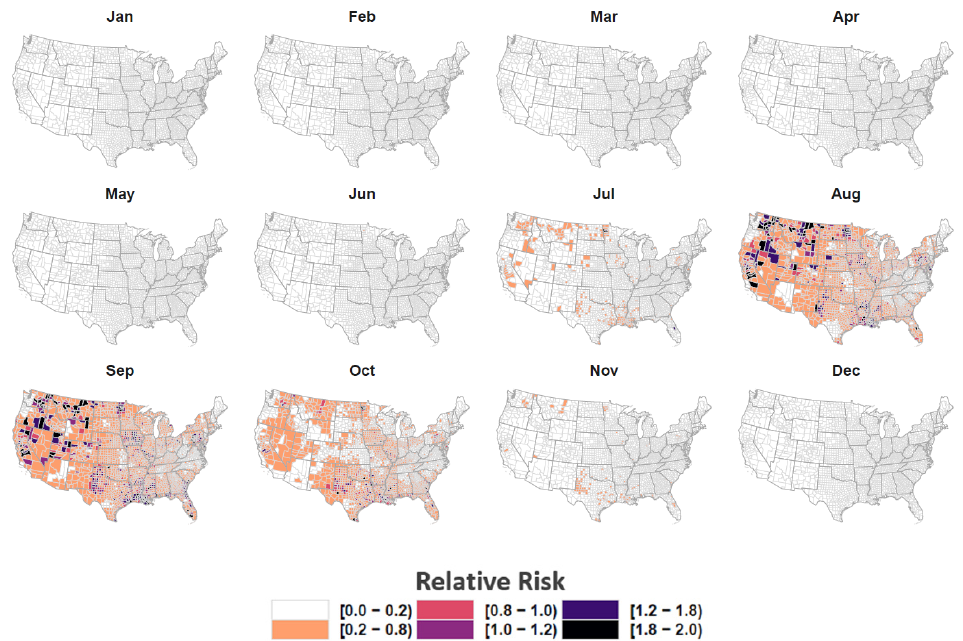
Figure A16. Spatiotemporal distribution of equine WND relative risk. Maps depict the spatial and temporal distribution of model estimated WND relative risk by US County and month of year. Maps are color coded according to legend at bottom such that darker tones signify increased risk and lighter tones represent relatively lower risk. A relative risk value of 1 indicates that model predicted cases were comparable to the expectation given the number of horses in the county, values below 1 highlight counties with relatively low risk, and values above 1 suggest increased risk (higher than expected given the horse population).